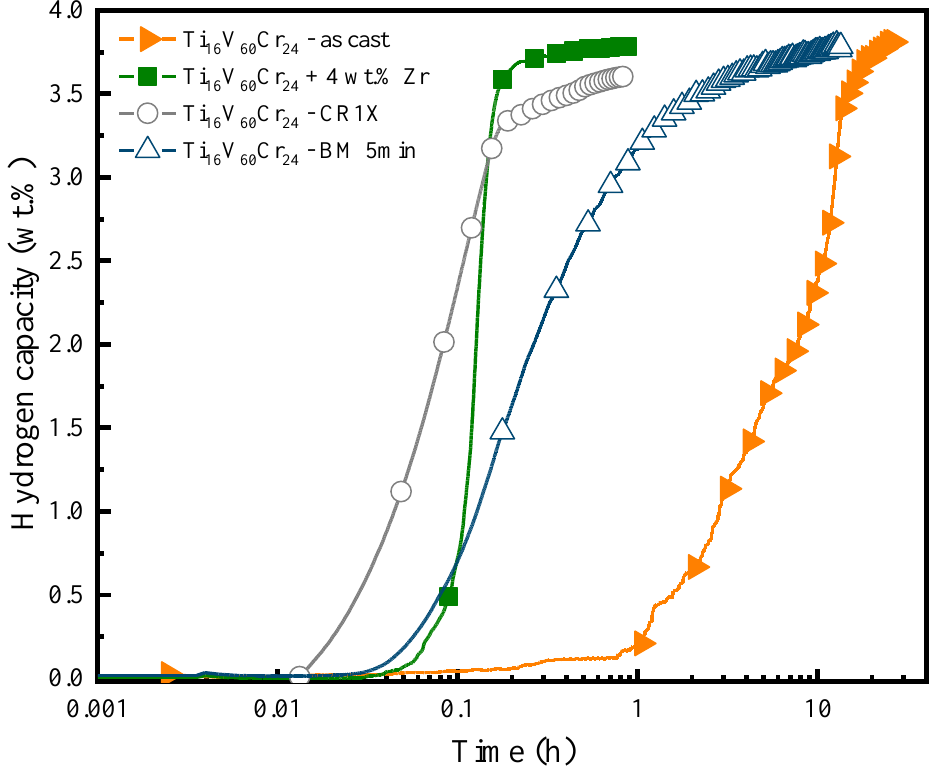
Figure 4. Activation curves of all samples at room temperature under hydrogen pressure of 30 bars.